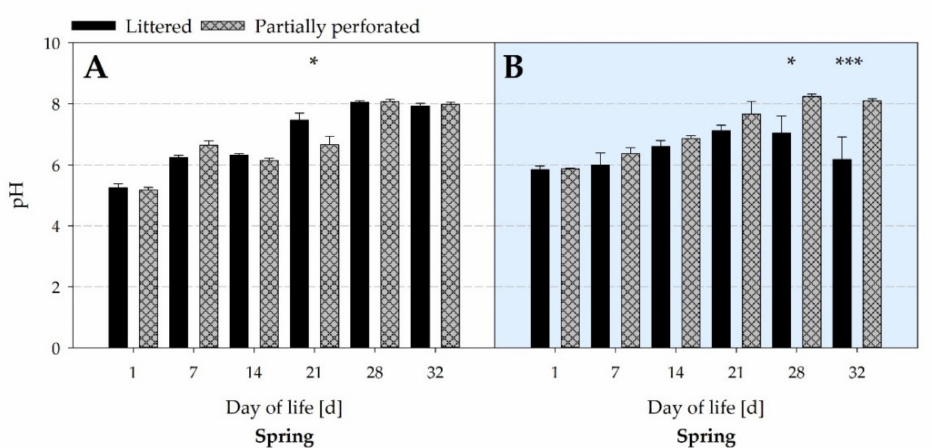
Figure 11. Average pH values of litter samples from ( A ) the littered side areas and ( B ) the supply area from broiler houses with two different floor types measured over the spring fattening period ( n = 6 values per day and barn in area ( A ); n = 3 values per day and barn in area ( B )). Significant differences are marked by asterisks: * p ≤ 0.05, *** p < 0.001.